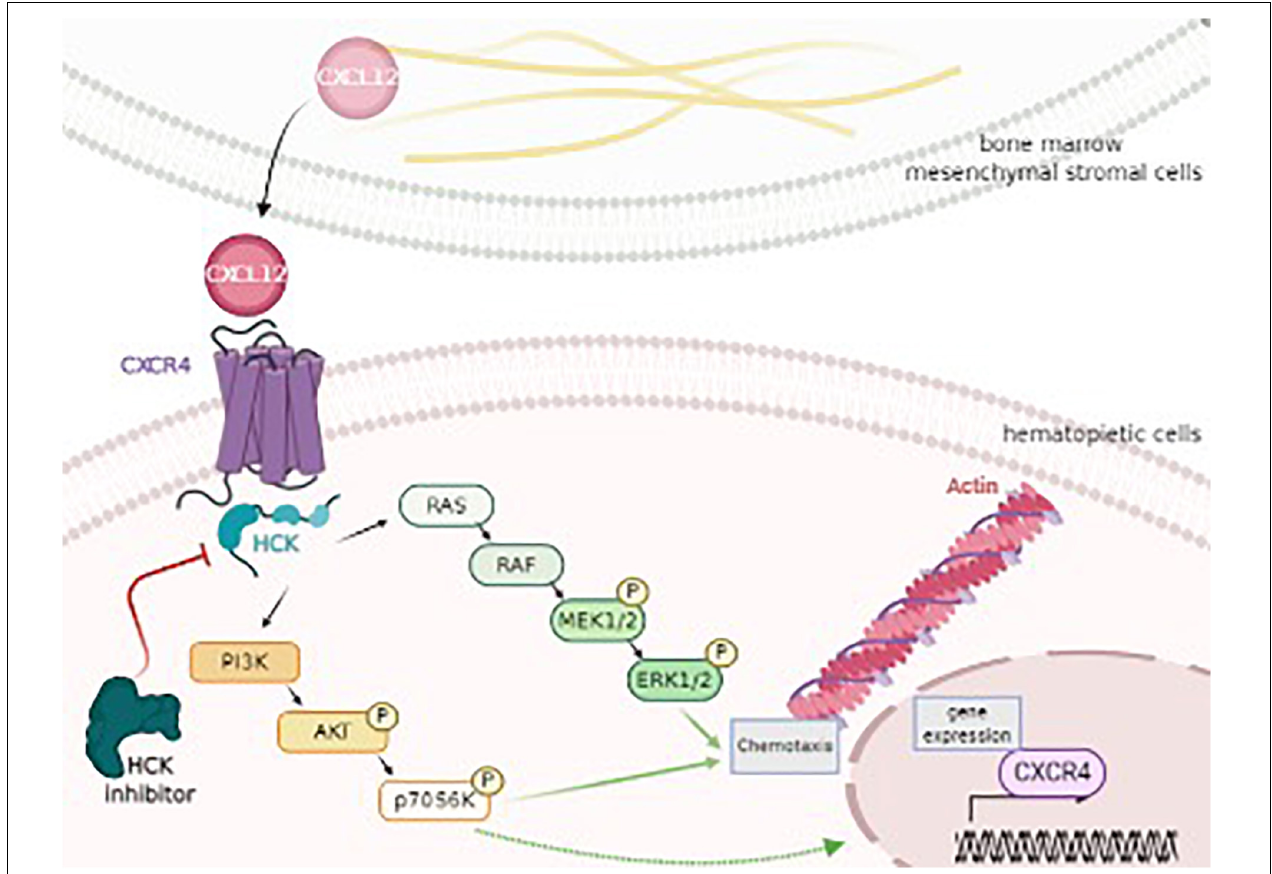
FIGURE 4 | HCK as a key target of CXCL12, CXCR4, PI3K/AKT, and MAPK/ERK signaling pathway, modulating chemotaxis and cytoskeleton activity. CXCL12 is secreted by bone marrow mesenchymal stromal cells and binds and triggers its receptor, CXCR4 on hematopoietic cells. This interaction results in the activation of HCK and, consequently, PI3K/AKT/P70S6K and MAPK/ERK pathways, regulating processes as chemotaxis, cytoskeleton (actin polymerization) and gene expression ( CXCR4 ). Thus, HCK could control the leukemic cell homing to the protective BM niche by a migratory advantage of leukemic cells and could represent a potential target for new therapeutical approaches for AML. Figure was produced using Servier Medical Art.